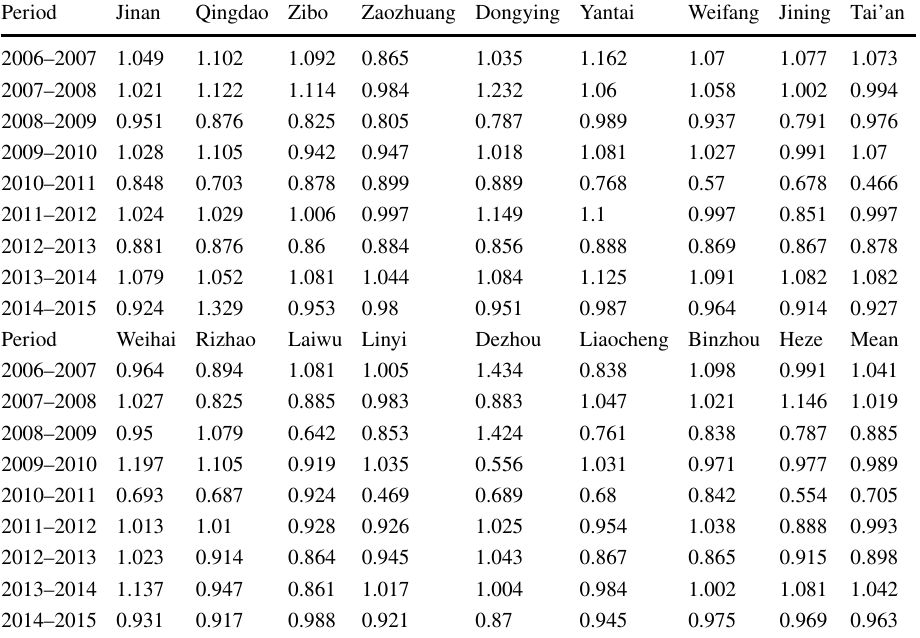
Fig. 2 Malmquist index trend of water use efficiency in Shan- dong Province for the